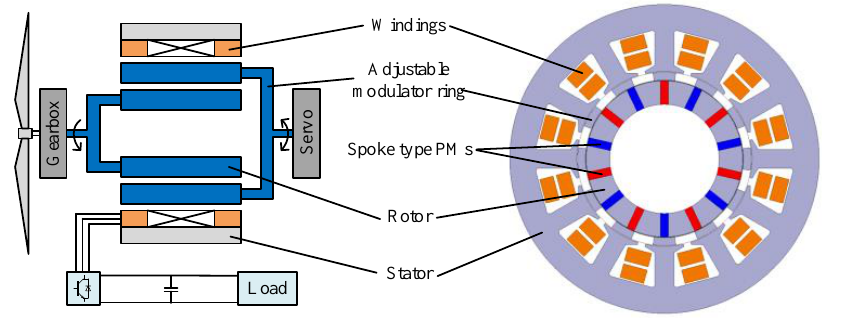
Figure 1. Configuration of the mechanical flux-weakening design of the PM generating system.